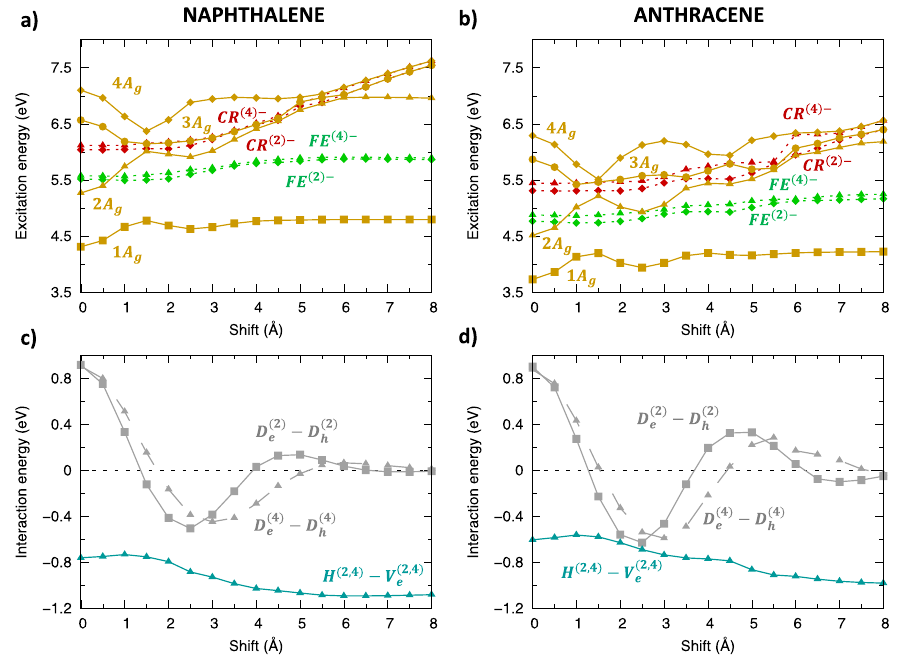
Figure 6. Analysis of the excitation energy profiles of singlet exciton states ( A g symmetry) for ( left ) naphthalene and ( right ) anthracene dimer (TDA- ω B97X-D/6-31G*) in terms of SA diabatic states (green for FE states, red for CR states) and their interactions. ( a , b ) Computed adiabatic and SA diabatic excitation energy profiles. ( c , d ) Magnitude and modulation along the longitudinal translation coordinate of the (grey) 𝐷 𝑒(2) − 𝐷 ℎ(2) , 𝐷 𝑒(4) − 𝐷 ℎ(4) interactions, coupling 𝐹𝐸 and 𝐶𝑅 states, and of the (dark-turquoise) 𝐻 (2,4) − 𝑉 interactions mixing 𝐹𝐸 (2) and 𝐹𝐸 (4) states.